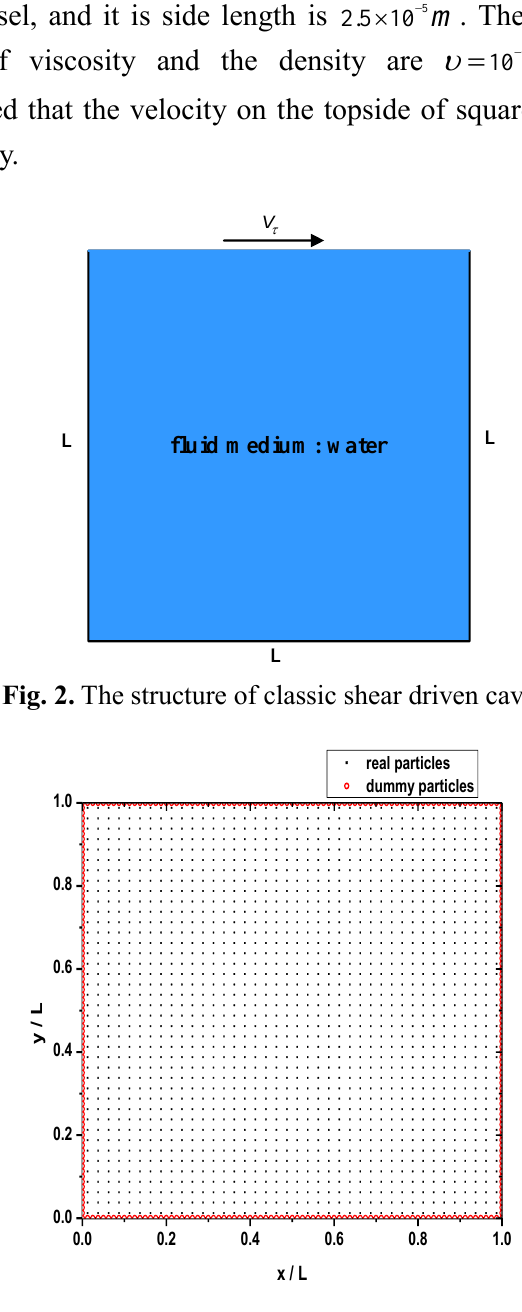
Fig. 3. The initial particle